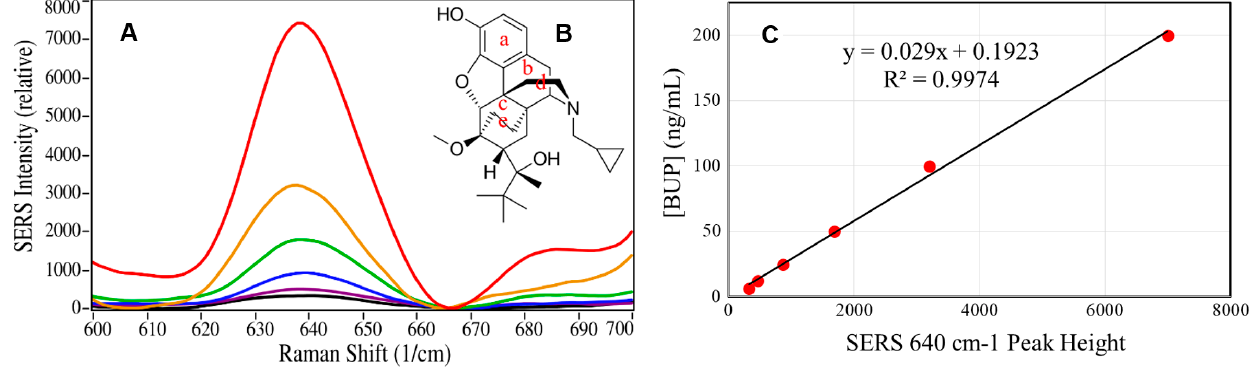
Figure 5. ( A ) Spectra of buprenorphine 638 cm − 1 peak, baseline-corrected at 665 cm − 1 , in pooled saliva, extracted and reconstituted at 6.25, 12.5, 25, 50, 100, and 200 ng/mL, ( B ) buprenorphine molecular structure, and ( C ) plot of buprenorphine concentration as a function of baseline-corrected 638 cm − 1 peak heights. Conditions as in Figure 1.